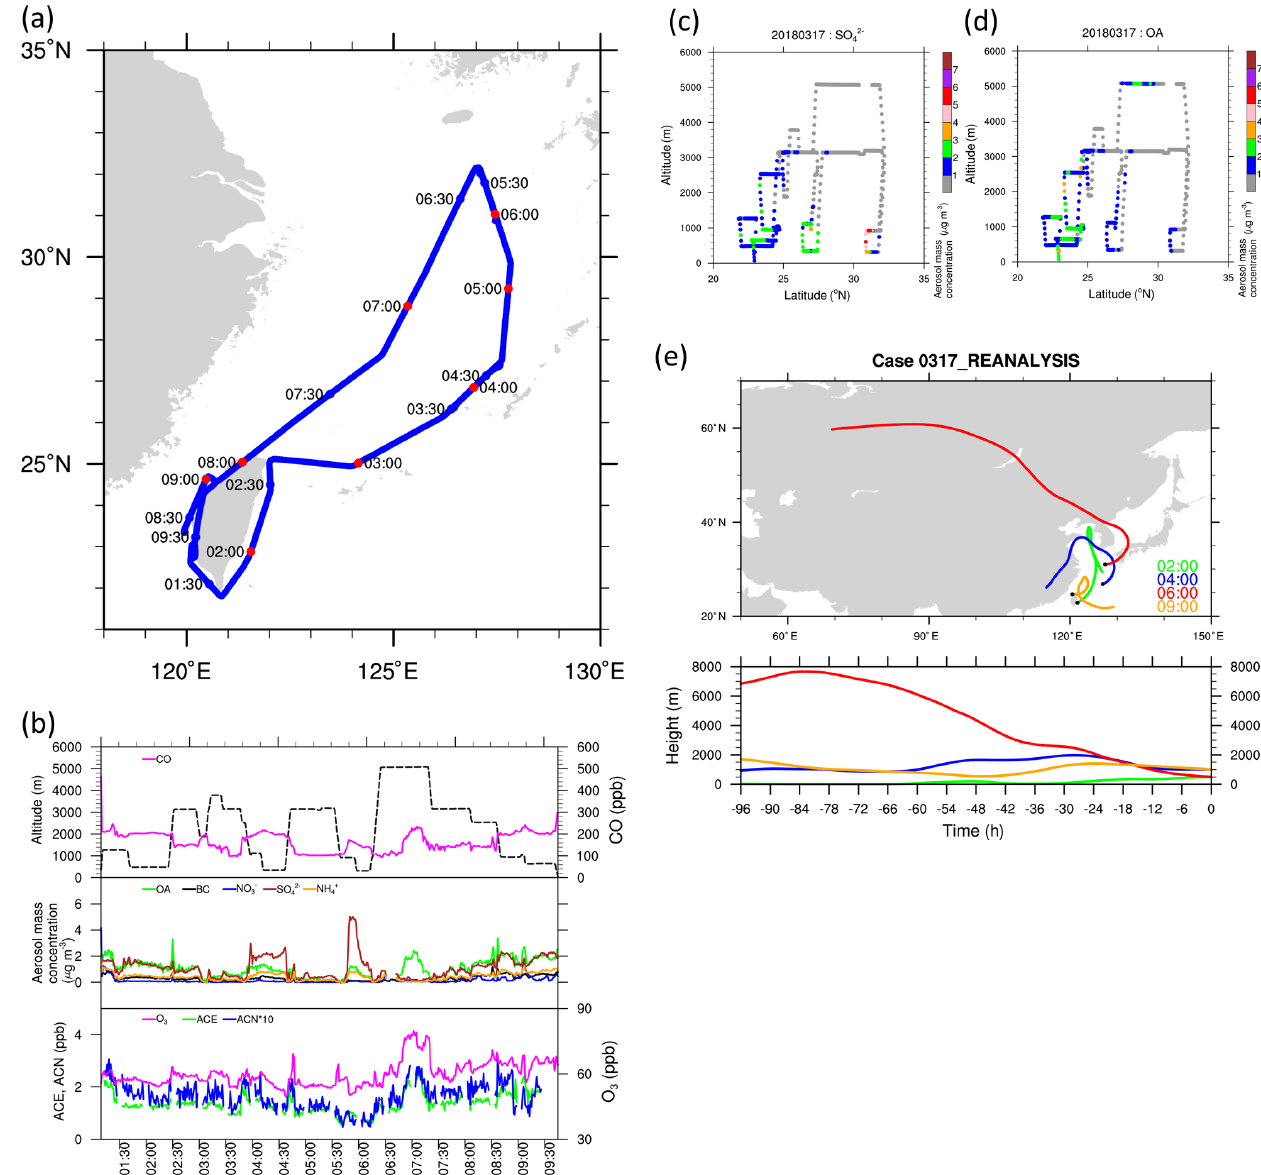
Figure 6. (a) The HALO flight and detailed locations on 17 March 2018. (b) Flight altitude and 1min mean of observed concentrations for CO (upper), organic aerosol (OA), BC aerosol (BC), SO 2 − , NO − , NH + (middle), O 3 , acetone (ACE), and acetonitrile (ACN) (bottom) on 17 4 3 4 March. (c) The observed SO 2 − mass concentration by HALO along with height–latitude variations on 17 March 2018. (d) The observed OA 4 mass concentration by HALO along with height–latitude variations on 17 March 2018. (e) Result of the HYSPLIT model backward-trajectory analysis started at the location of the HALO flight path at 02:00, 04:00, 06:00, and 09:00UTC on 17 March